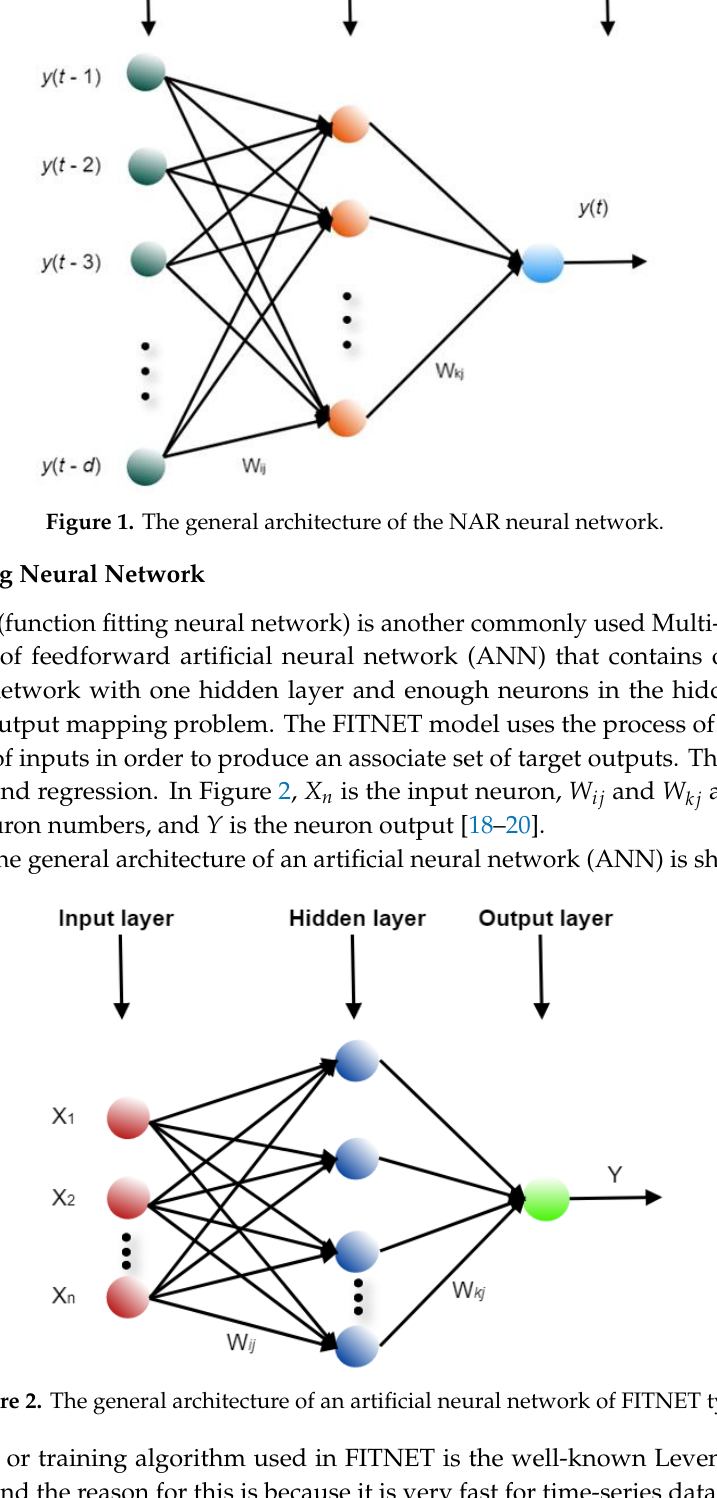
Figure 2. The general architecture of an artificial neural network of FITNET type.